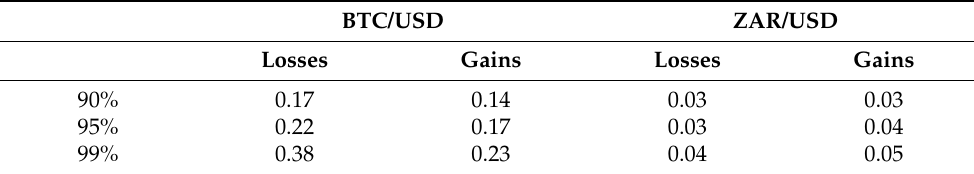
Table 4. VaR estimates.